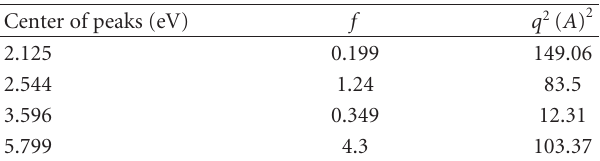
Table 4: Values of the center of the absorption band, oscillator strength, and electric dipole strength for as-deposited (PTCDI) thin